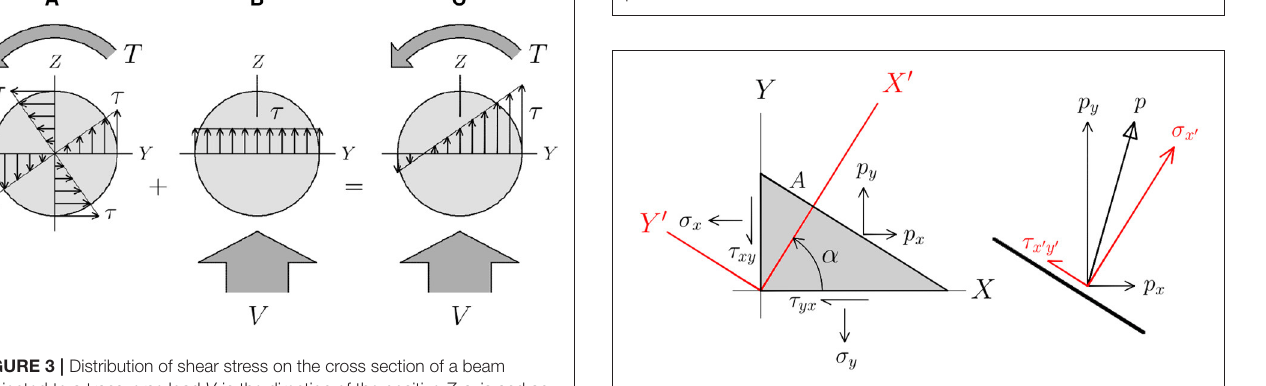
FIGURE 5 | Free body with stress components on all surfaces. Decomposition of the stress vector p relative to the X ′ Y ′ -coordinate system is shown in red, decomposition relative to the XY -coordinate system is shown in black. The surface area of the inclined plane is A